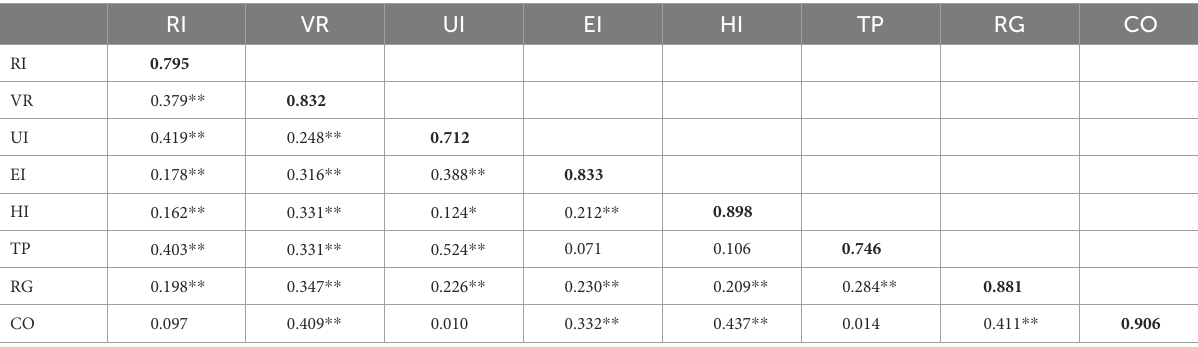
TABLE 2 Distinct validity